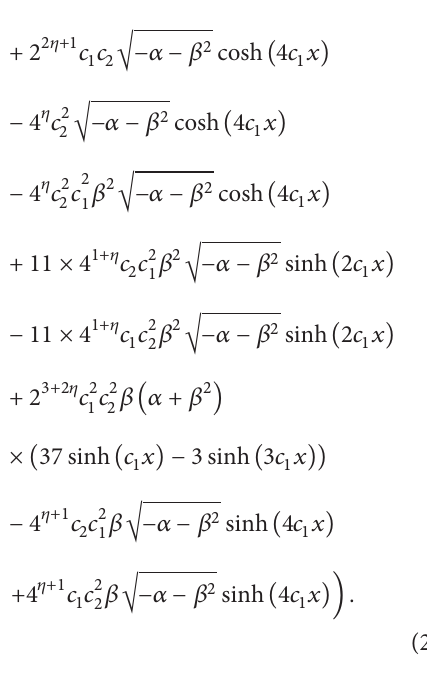
Figure 1: Approximate solution for FWBK